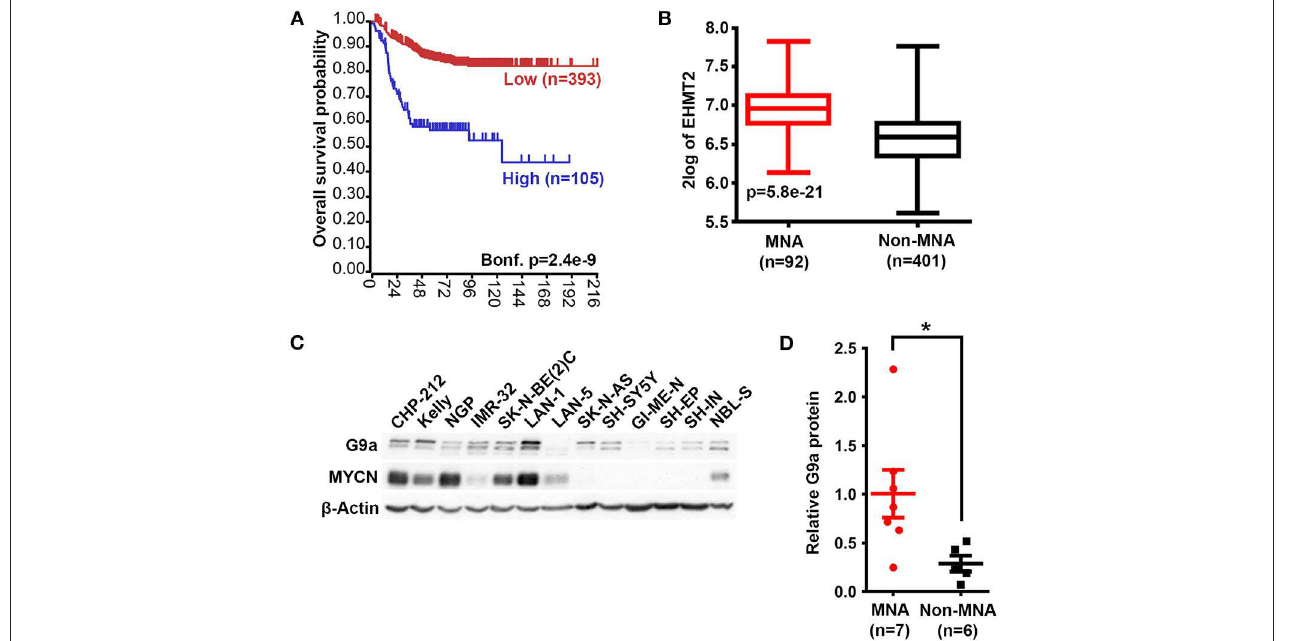
FIGURE 1 | G9a mRNA and protein expression correlate with poor prognosis and MYCN amplification. (A) Kaplan–Meier analysis showing that high expression of G9a correlates with poor prognosis in primary NB (SEQC, GSE62564). Bonferroni-corrected p -values of log rank test are shown. (B) Significantly higher G9a mRNA expression is observed in MNA neuroblastoma relative to non MNA. The p -values are calculated by one-way ANOVA. (C) Immunoblot of G9a protein expression in a panel of MYCN -amplified and non- amplified NB cell lines. β -Actin is used as a loading control. Representative of n = 3. (D) Scatter dot plot of relative G9a protein is generated from semi-quantitative densitometry of blots from (C) . G9a protein expression is higher in MNA neuroblastoma when normalized to β -Actin. Significance measured by unpaired T test (* p <